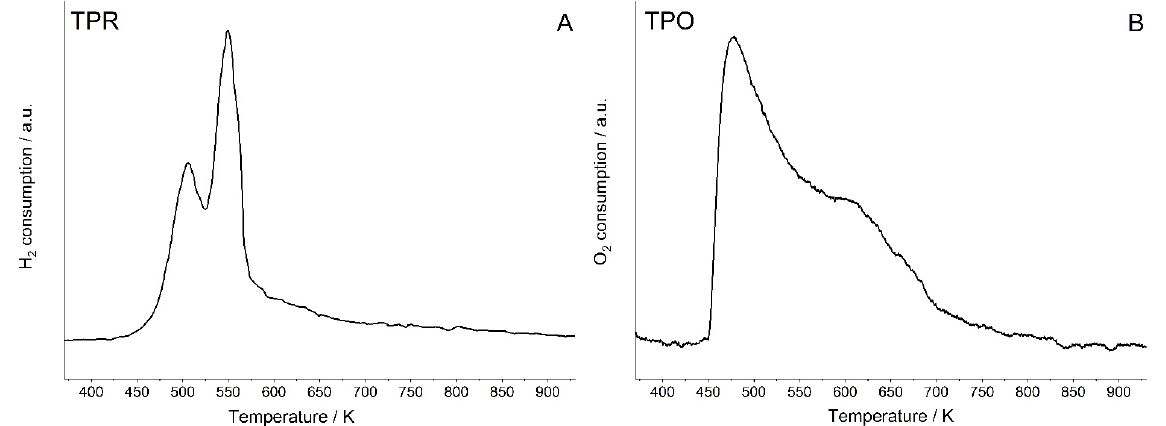
Figure 4. Temperature-programmed reduction (TPR) ( A ) and oxidation (TPO) ( B ) diagrams of CuY.